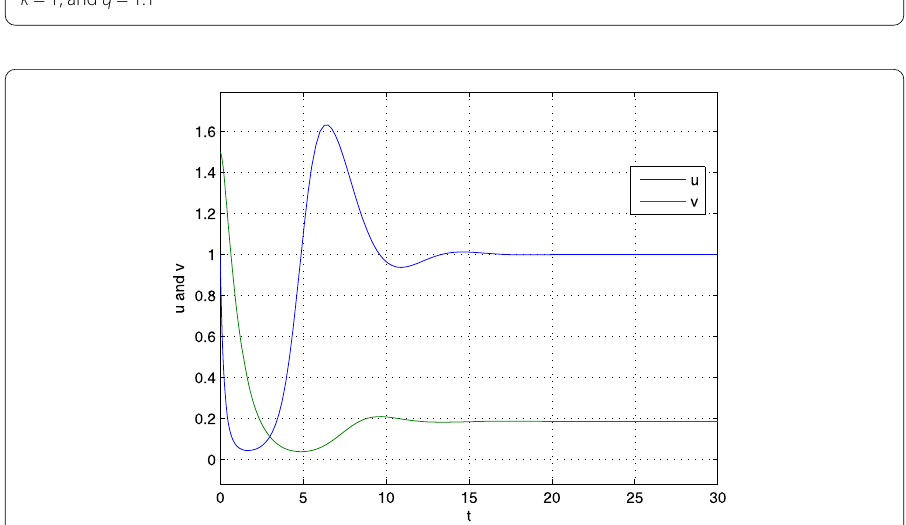
Figure 11 Dynamic behavior of system (1.1) with r 0 = 4, d = 1, a = 1, p = 2, E = 1, m 1 = 1, m 2 = 0.1, c = 0.5, k = 1, and q =